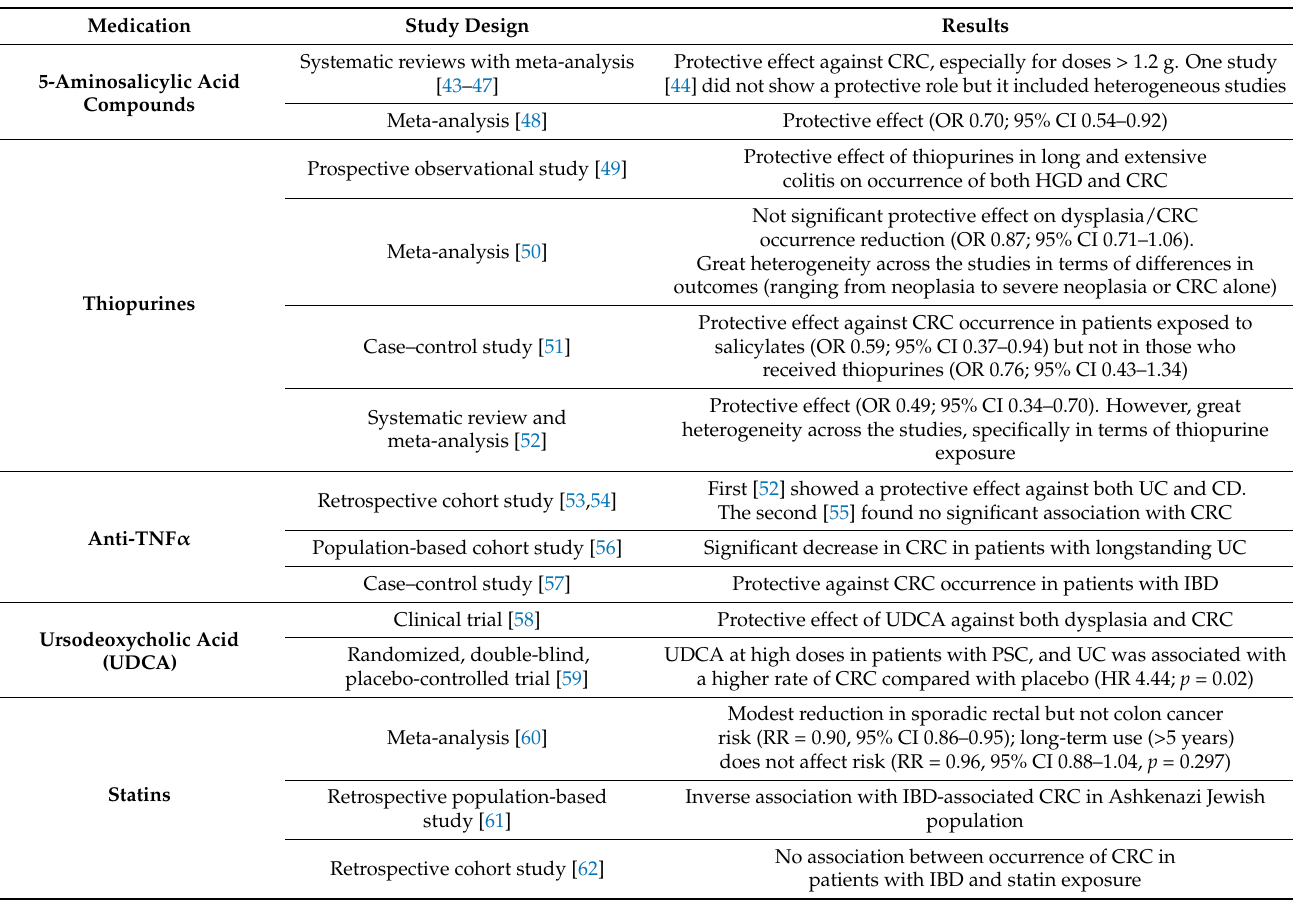
Table 1. Summary of the principal studies on CRC chemoprevention in IBD